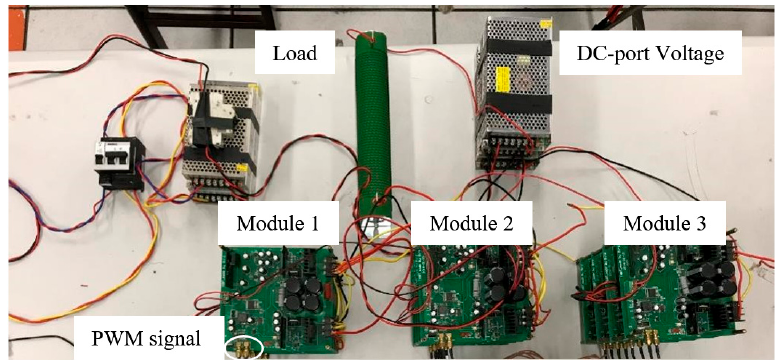
Figure 12. Three-module prototype of 3LNPC-CC.